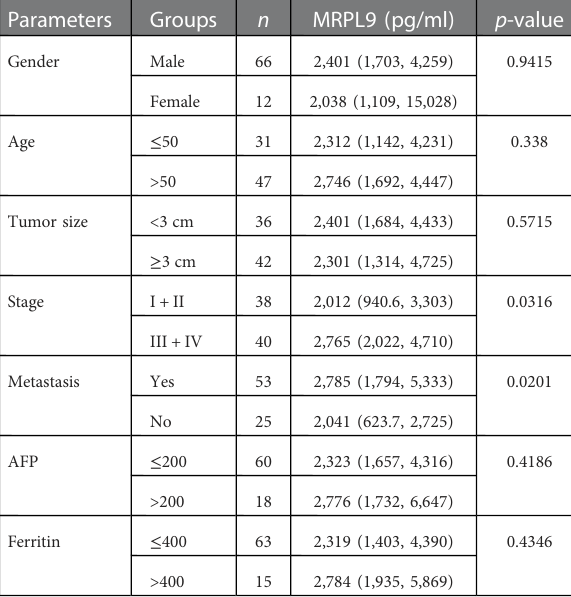
TABLE 2 Correlations of serum MRPL9 level and different clinical pathological parameters of